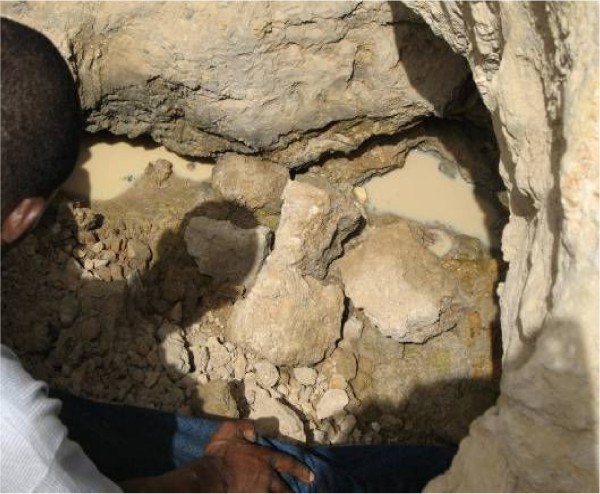
Brick-hole in Zongo district